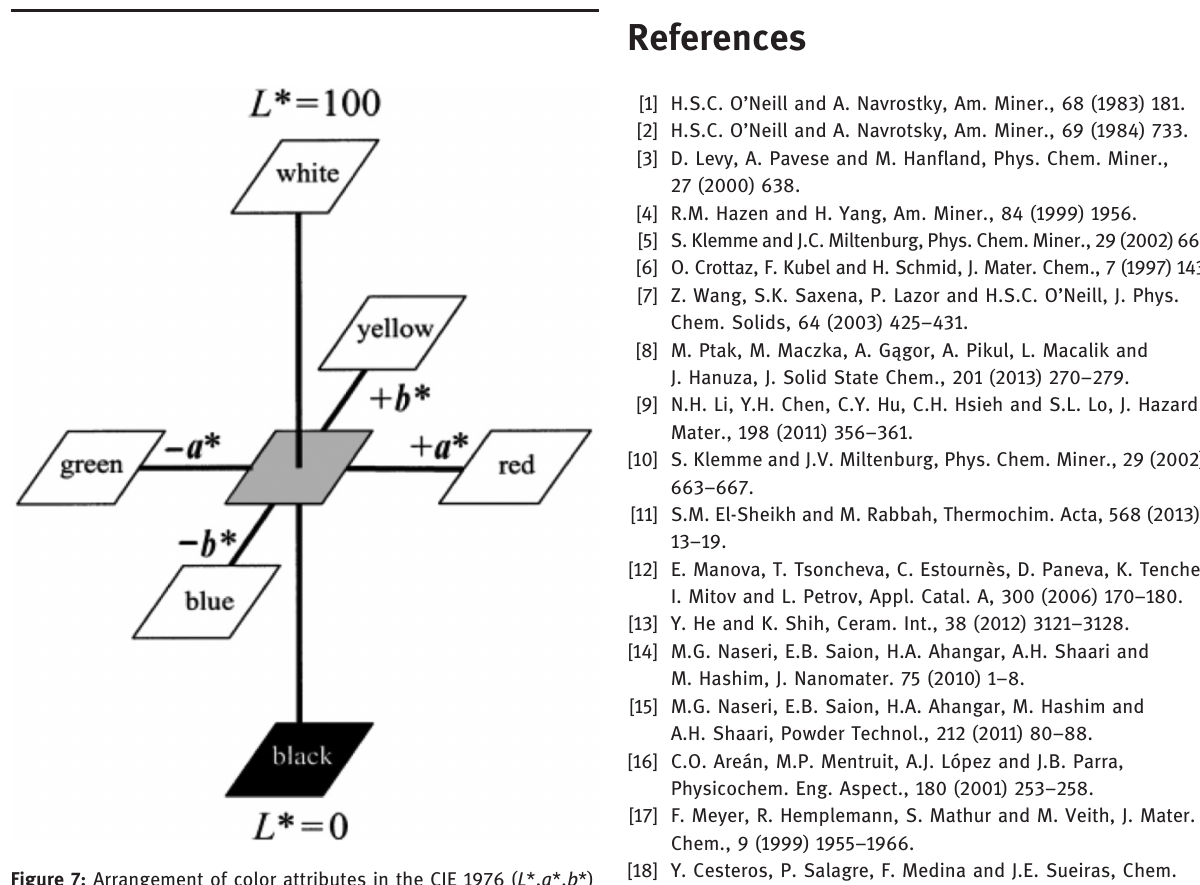
Figure 7: Arrangement of color attributes in the CIE 1976 ( L *. a *. b *) color space.